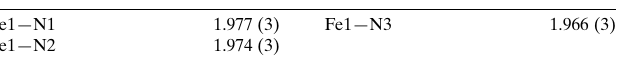
Selected bond lengths (A˚ ).